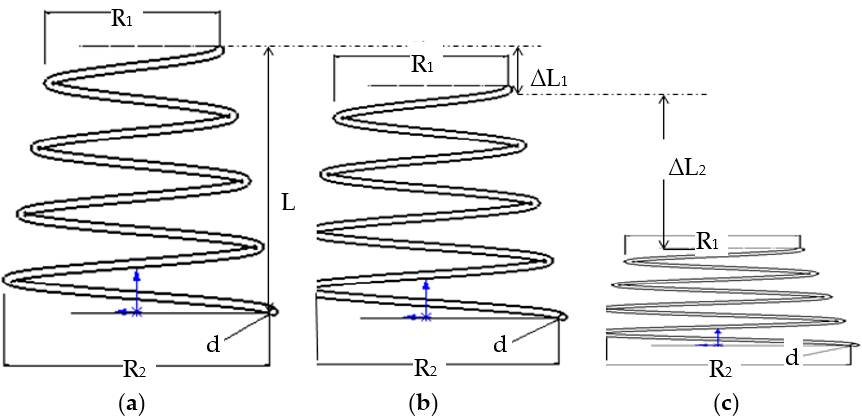
Figure 14. Simulation schematic diagram of the spring force and deformation with RecurDyn. ( a ) Spring original state; ( b ) The state after the pressure plate is installed; ( c ) The state at the time of maximum compression deformation.